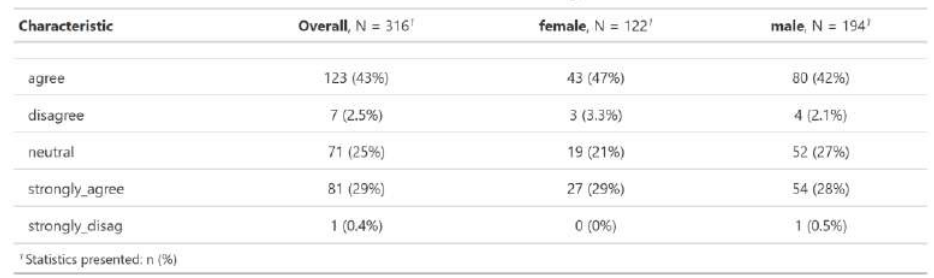
Table 29: India is considered the largest democracy in the world. With its huge Muslim population, do